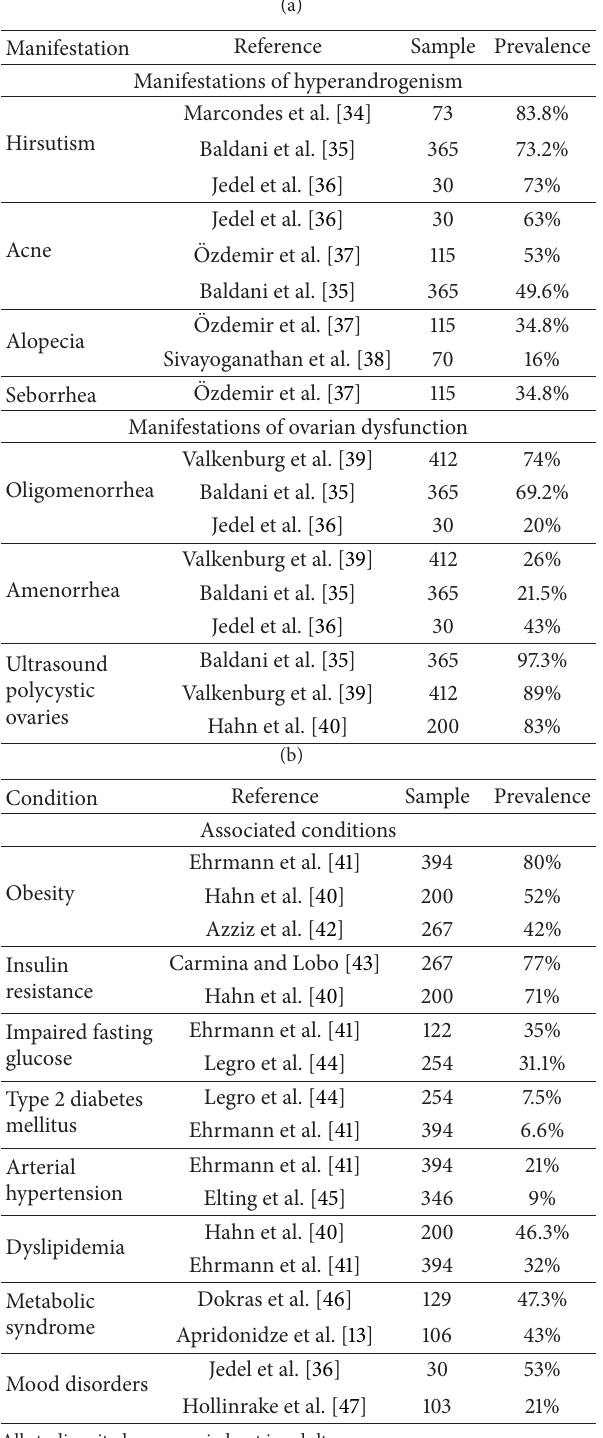
Table 1: Clinical manifestations and conditions associated with polycystic ovary